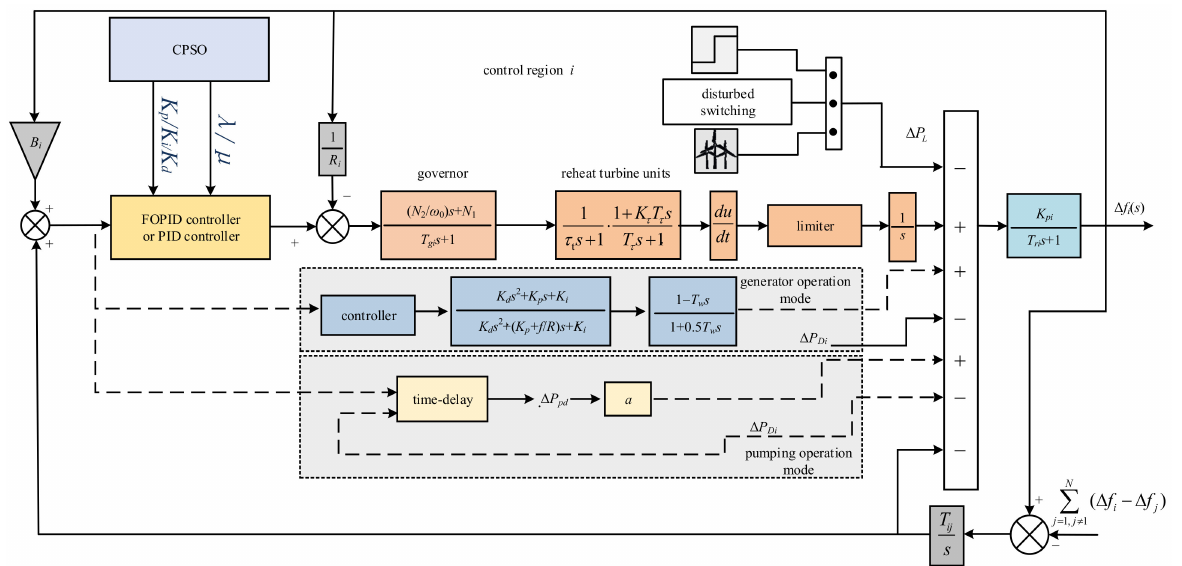
Figure 1. The model of a single region containing pumped